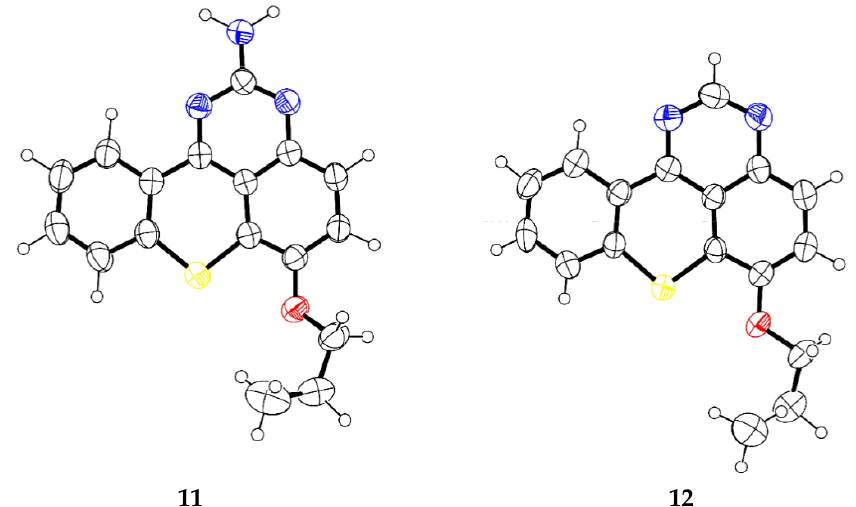
Figure 4. ORTEP view of compounds 11 and 12 .